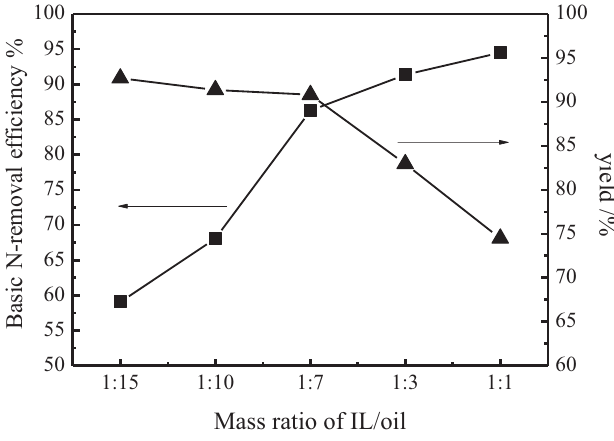
Fig. 5 Fig. 5 – Effect of mass ratio of IL/oil on denitrogenation pro- cess. Reaction conditions: reaction temperature = 30 °C, reaction time = 20 min, settling time = 2